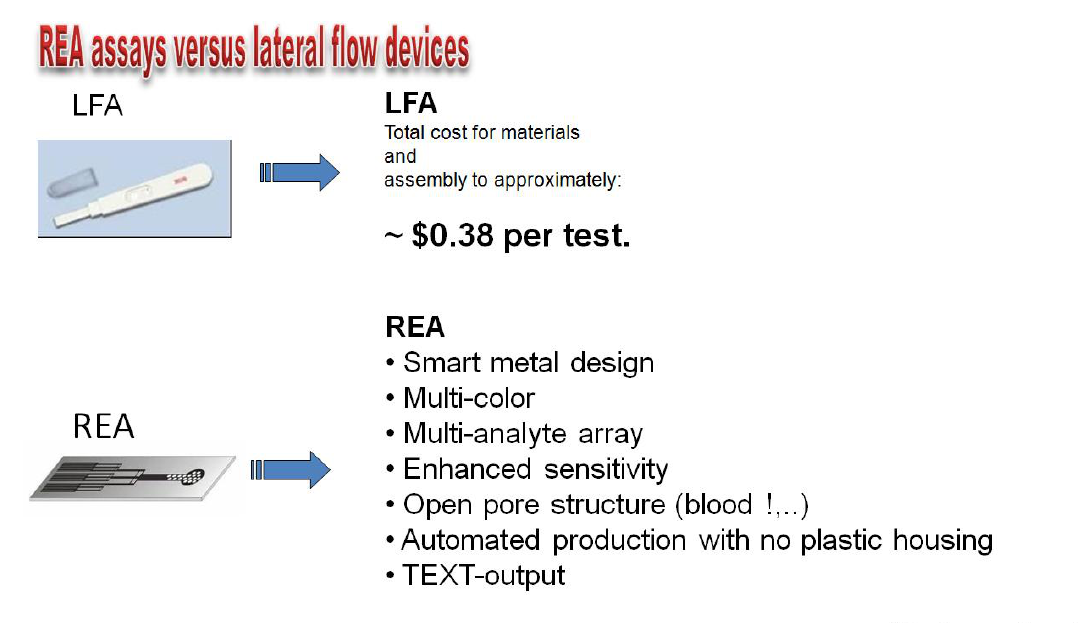
Figure 10. Comparison of features: LFA compared to resonant nanocolor quick